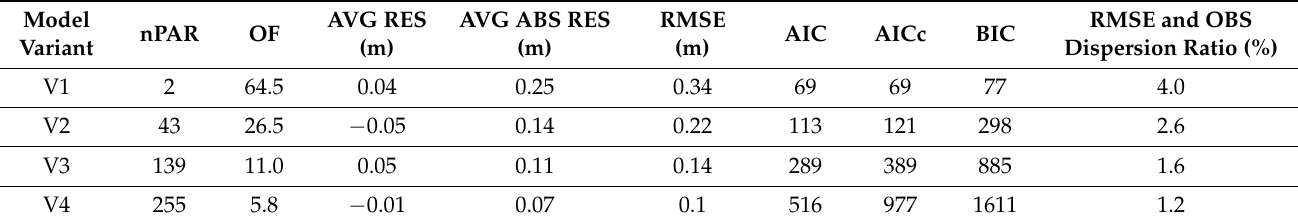
Table 2. Calibration characteristics of individual model variants .